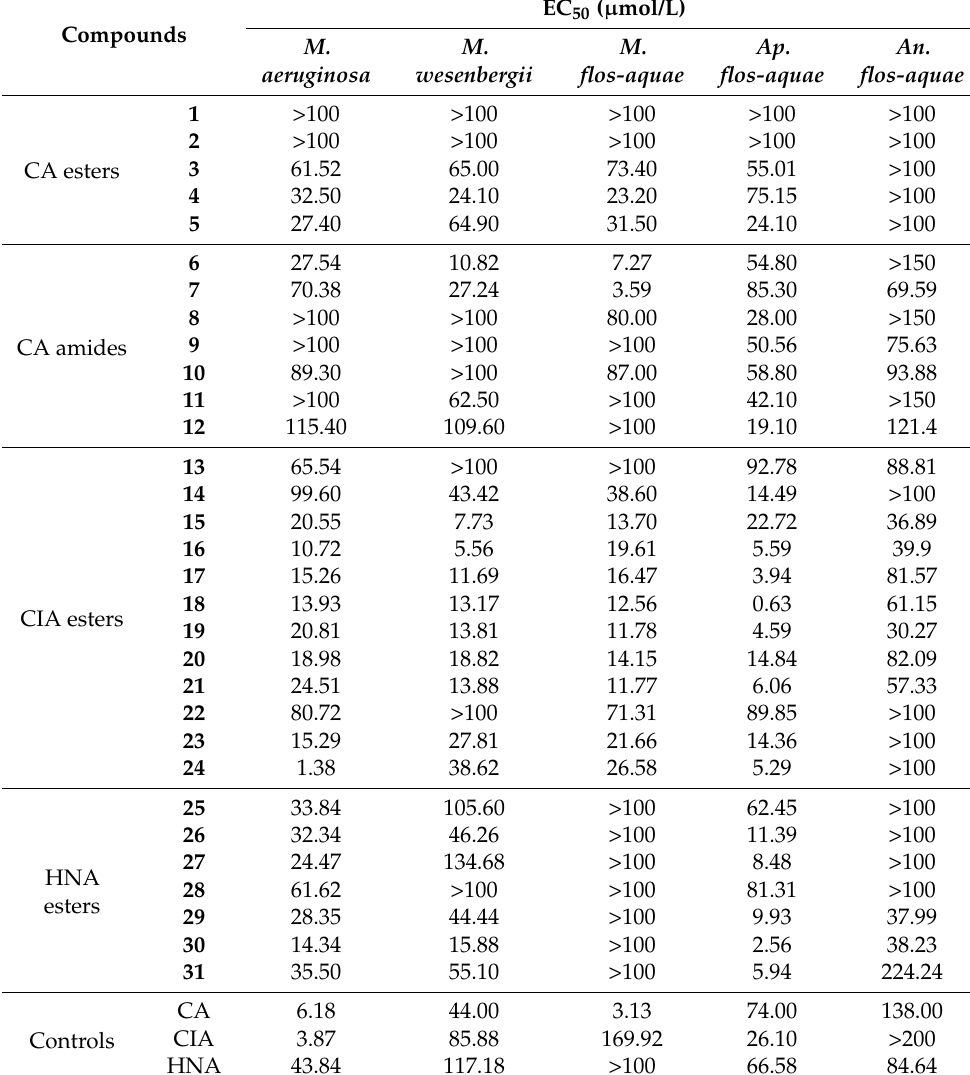
Table 1. Algicidal activities of the synthesized compounds 1 – 31 and parent